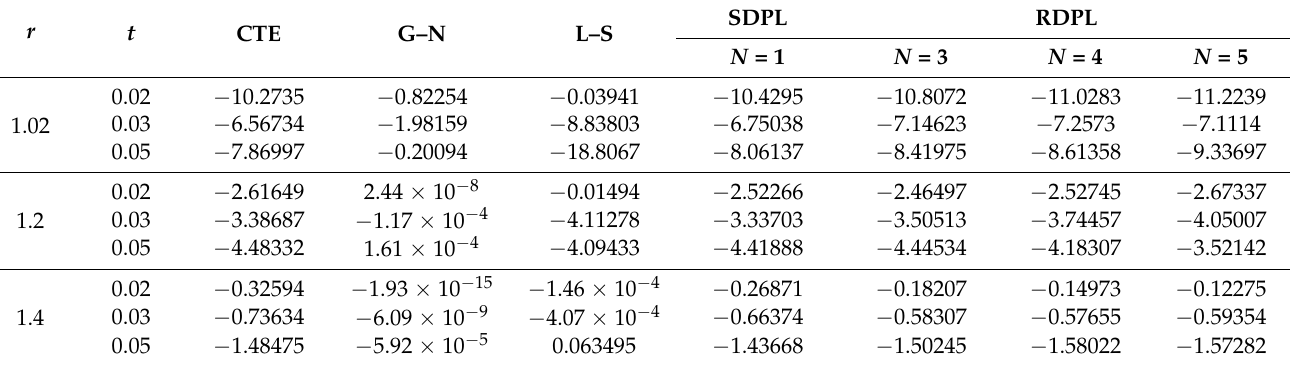
Table 5. Effects of dimensionless time t on circumferential stress σ 2 according to different thermoelas- ticity theories with several values of r